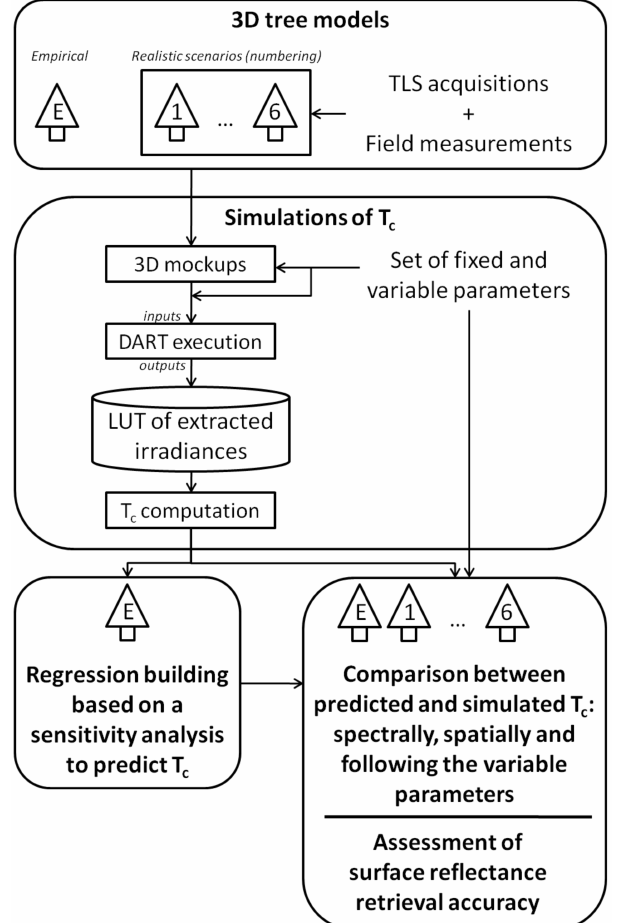
Figure 2. General methodological